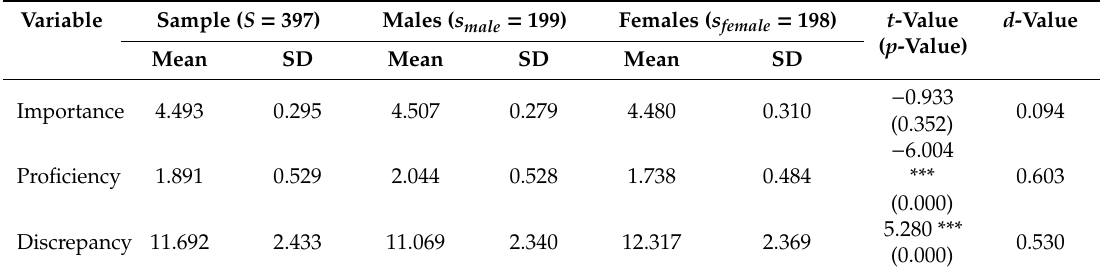
Table 6. Training need comparison between male and female